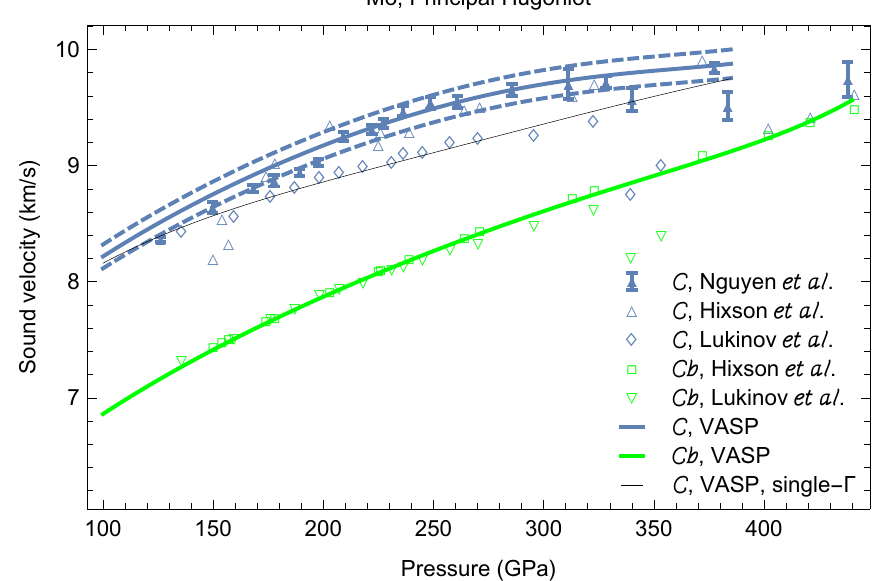
Figure 3. Sound velocities in bcc-Mo along the principal Hugoniot: unified analytic melt-shear model vs. experimental data. The 3 σ -wide confidence interval around the model curve is shown with dashed